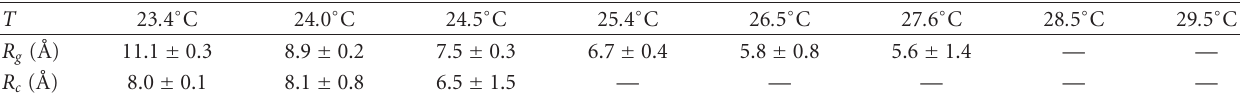
Table 1: Structural data obtained by Guinier analysis of the experimental SAXS curves. R g is the particle gyration radius, while R c is the gyration radius of the particle cross section [21,